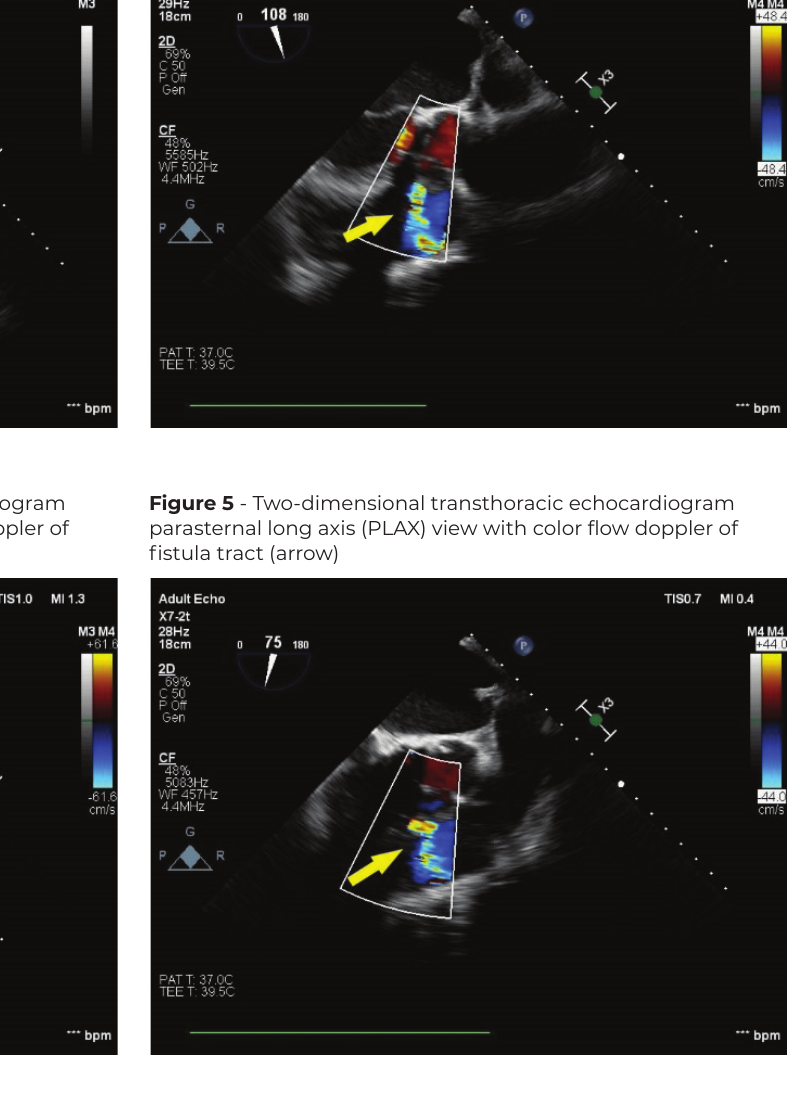
Figure 3 - Two-dimensional transthoracic modified subcostal view with color flow doppler of fistula tract